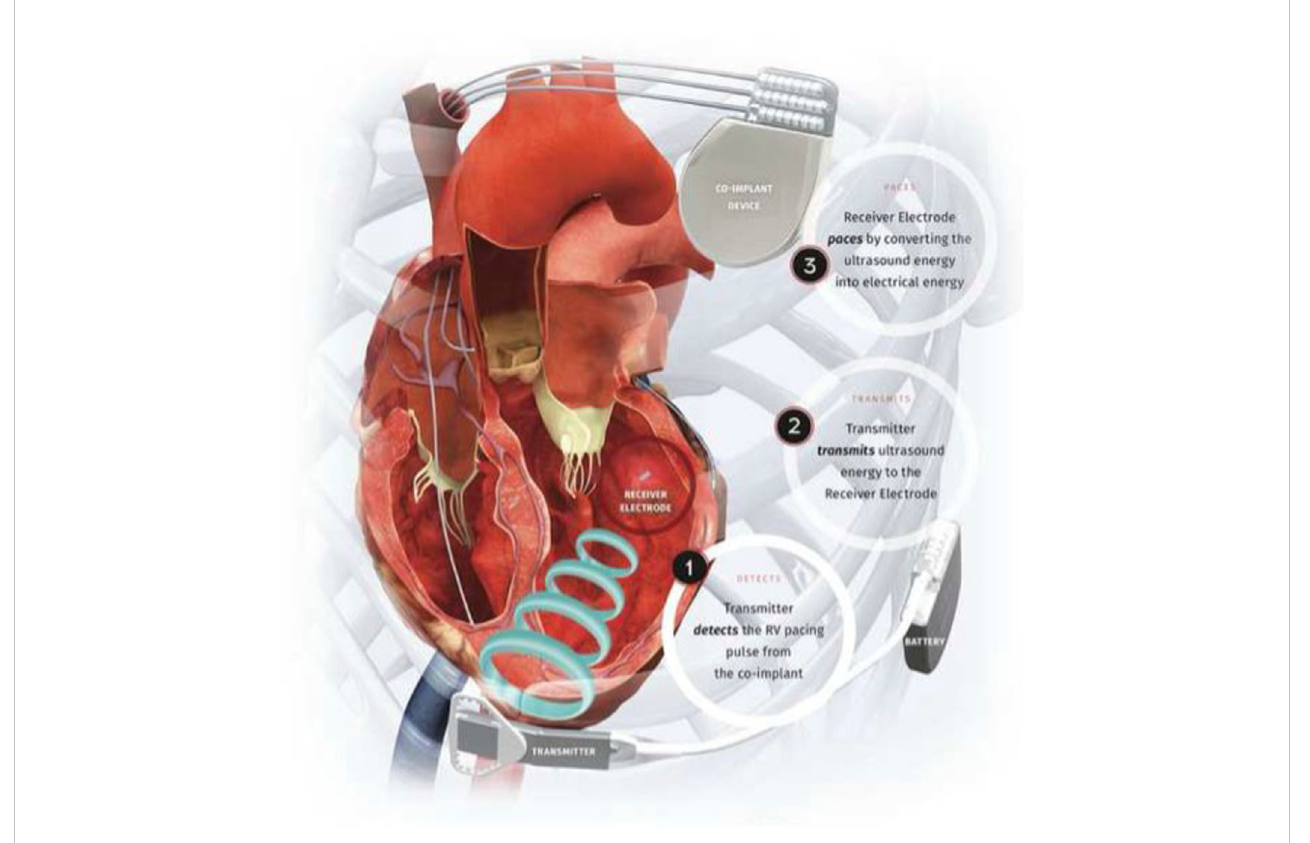
FIGURE 2 Components of the WiSE-CRT System. Reproduced from reference 64, Elliott et al., with permission.